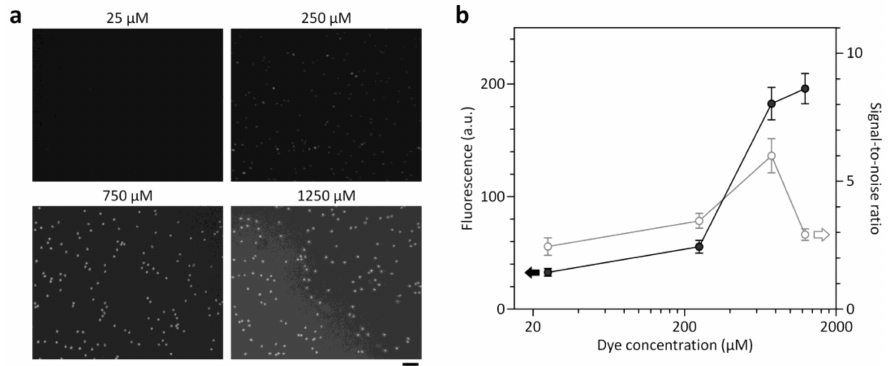
Figure 3. Effect of different dye concentrations on the fluorescence intensity of stained WBCs (signal) and background fluorescence (noise). ( a ) Fluorescence images of WBCs in the counting chamber at dye concentrations ranging from 25 to 1250 µ M. Each micrograph was taken with the miniaturized microscope 10 min after introducing WBC samples. Scale bar, 50 µ m. ( b ) The signal-to-noise ratio peaked at 750 µ M, while the fluorescence intensity saturated at higher concentrations. Error bars: s.d. ( n = 10).